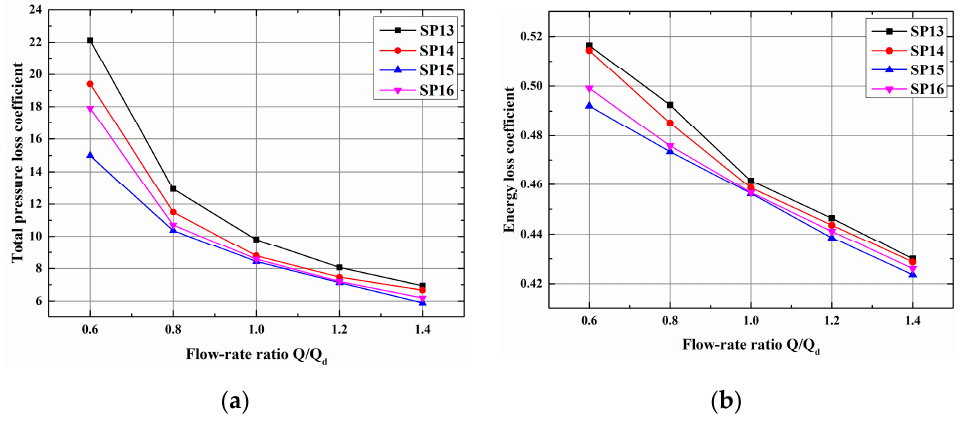
Figure 13. Variation in the pressure and the energy loss coefficient with respect to mass flow rate (S offset = 0.6): ( a ) Curve of total pressure loss coefficient; ( b ) curve of energy loss coefficient.